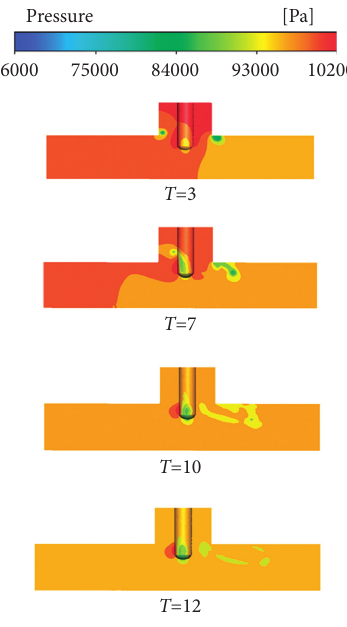
Figure 5: Pressure